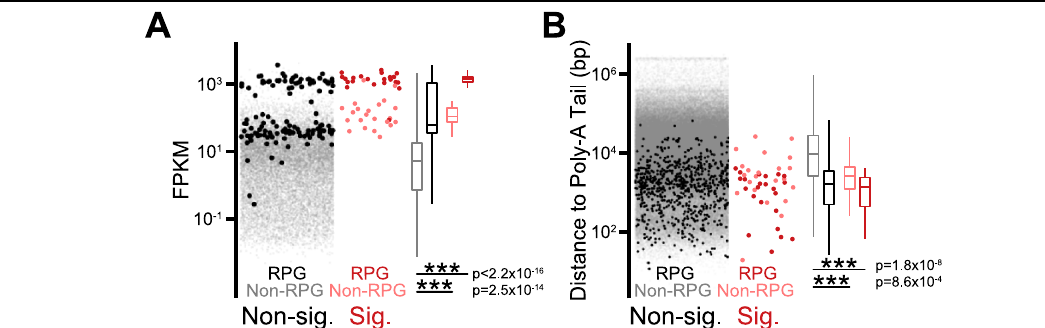
Fig. 2 | Selection bias in identi fi ed intron retention events. A Expression (mea- sured in Fragments per Kilobase per Million Reads) of all introns versus those identi fi ed as retained broken out by ribosomal protein genes (RPG) and non- ribosomal protein genes (Non-RPG). B Distance from intron to poly-A Tail for all